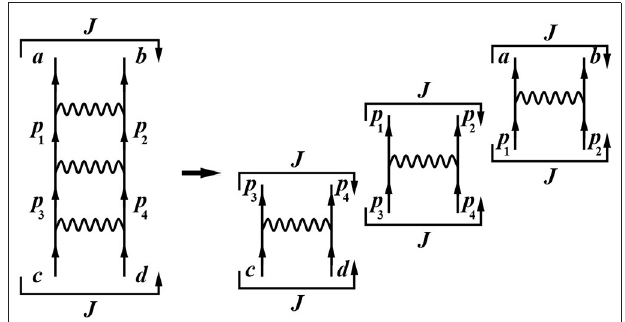
FIGURE 4 | Two-body ladder diagram at third order in perturbation theory: lines with arrows represent incoming/outgoing and intermediate particle states; wavy lines represent interaction vertices.